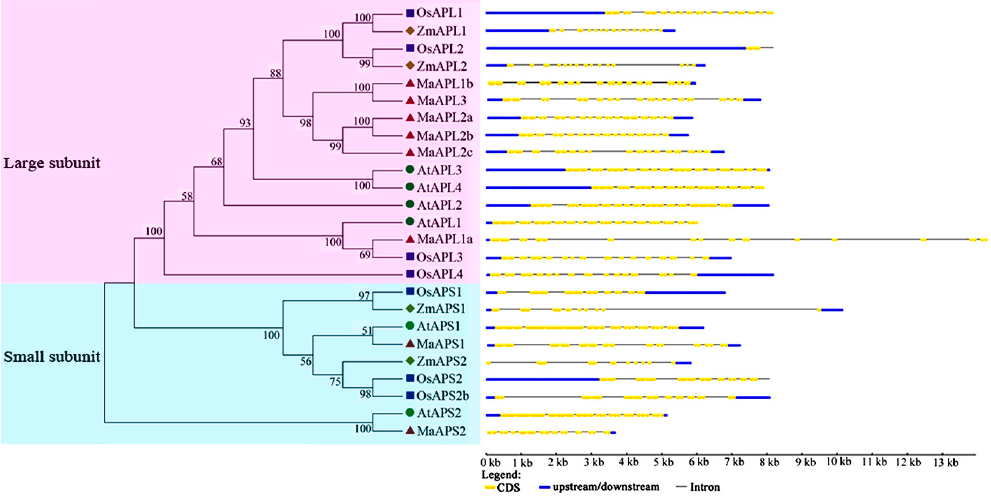
Figure 2. Gene structure analyses of MaAGPases . Exon-intron structure analyses were performed using the Gene Structure Display Server database. Blue boxes indicate upstream/downstream; yellow boxes indicate exons; black lines indicate introns. The circle, square, diamond, and triangle represent AGPase proteins from Arabidopsis, rice, maize, and banana, respectively.